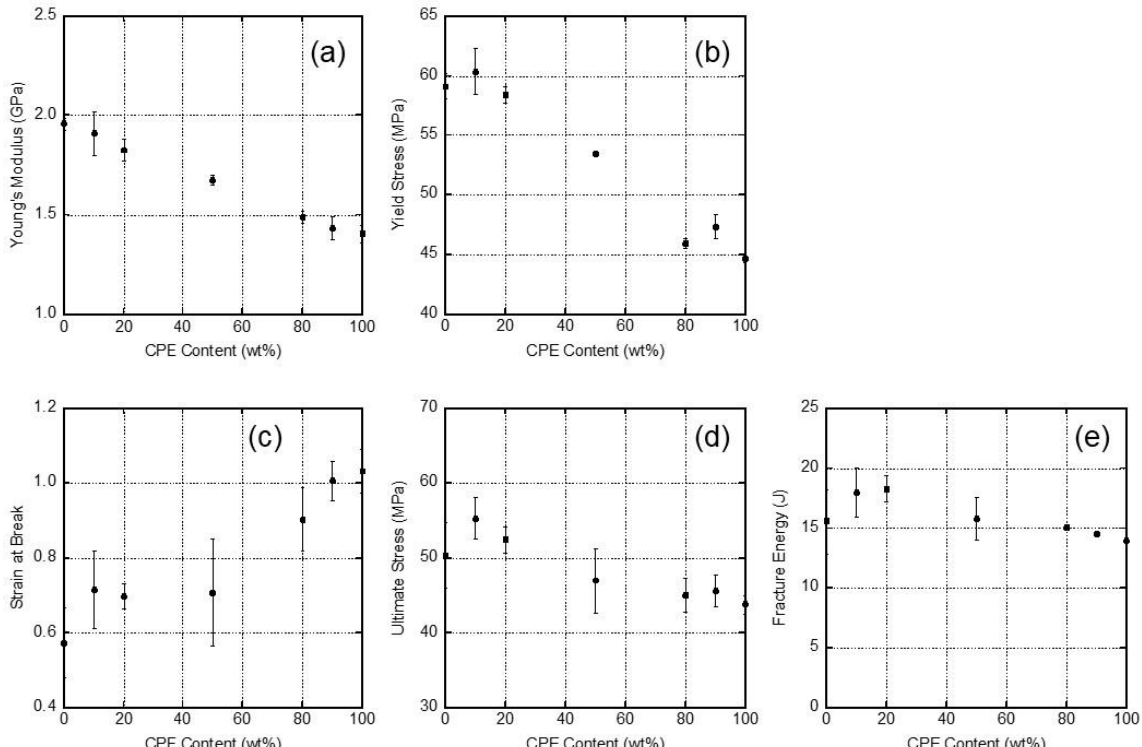
Figure 9. Tensile properties as a function of the CPE content: ( a ) Young’s modulus, ( b ) yield stress, ( c ) strain at break, ( d ) ultimate stress, and ( e ) fracture energy.